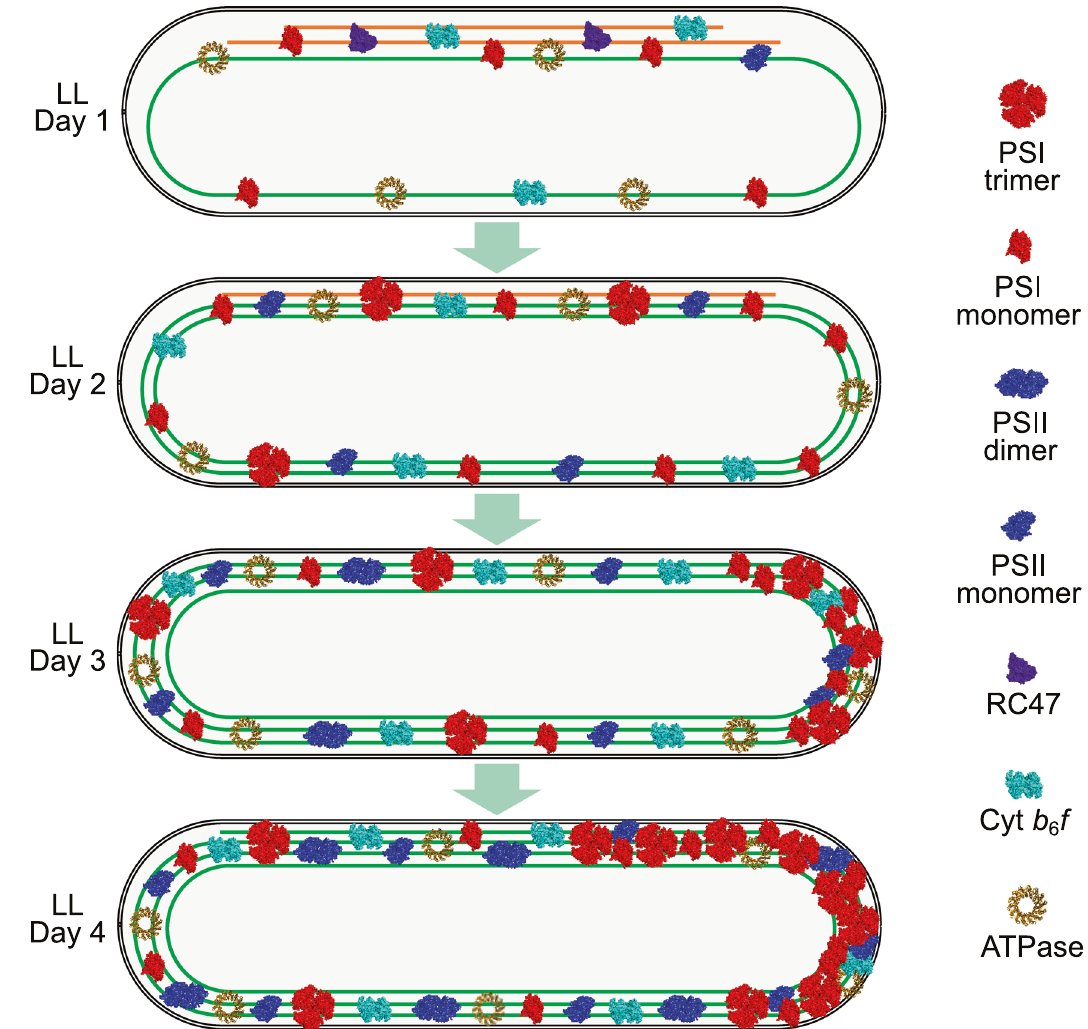
Fig. 6 A schematic model representing the generation and distribution of both thylakoid membrane and photosynthetic protein complexes, including their oligomerization state, at different stages of thylakoid biogenesis in Synechococcus . Note that the number of individual complexes has no direct links to their real stoichiometry in situ. Existing membrane parts are in green and new ones in orange during the initial steps of the thylakoid biogenesis process. The schematic models of photosynthetic complexes were generated based on their PDB structures. PDB ID: PSI trimer and monomer, 1JB0; PSI dimer and monomer and RC47, 3WU2; Cyt b 6 f , 2E74; ATPase,